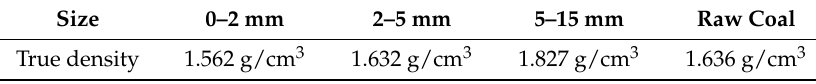
Table 3. True densities of coal measured for different size classes of coal particles.